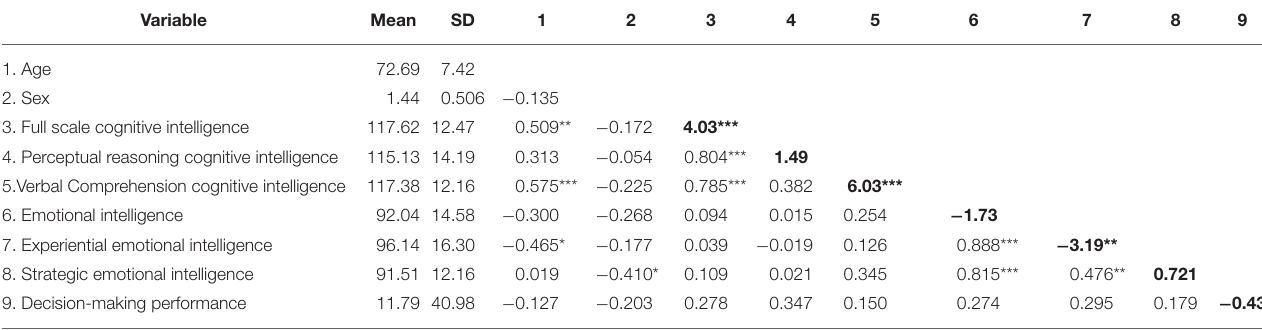
TABLE 1 | Means, standard deviations, and correlations among study variables. Variable